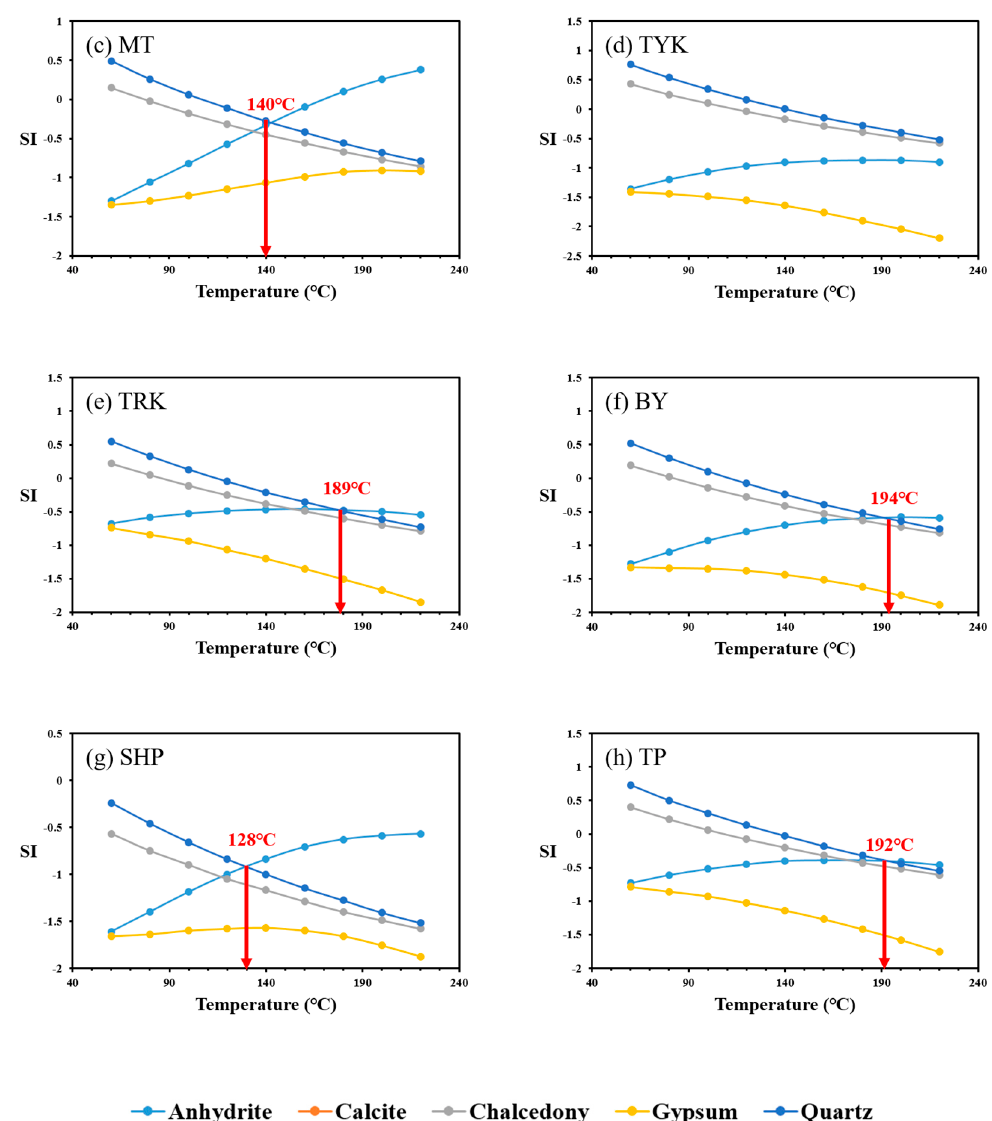
Figure 7. Multicomponent geothermometry for Tatun geothermal field hot spring waters .